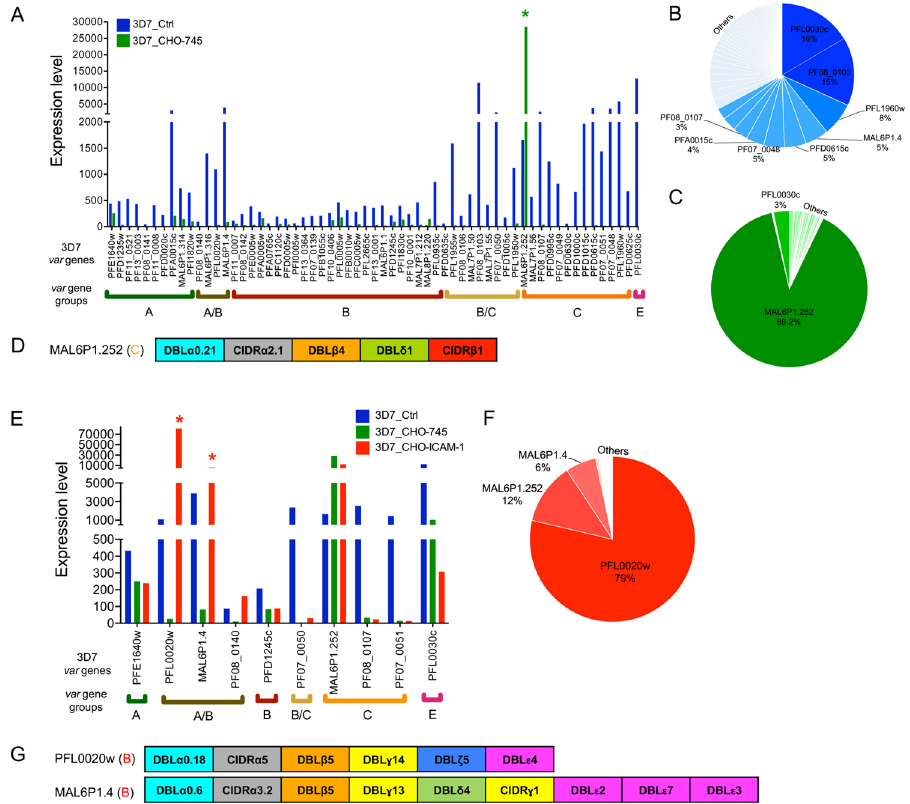
Figure 5. Enrichment of a P. falciparum 3D7 population for parasites binding to CHO-745 WT cells (3D7_CHO-745) and for ICAM-1–binding parasites (3D7_CHO-ICAM-1). ( A ) var gene expression in long-term cultured 3D7 parasites (3D7_Crtl) and 3D7_CHO-745 parasites (expression level is defined as average of the normalized read counts). A var gene with significantly increased expression in 3D7_CHO-745 parasites in comparison with 3D7_Ctrl parasites is marked by a green star (padj < 0.05). ( B ) Distribution of var gene expression in the 3D7_Ctrl population. ( C ) Distribution of var gene expression in the 3D7_CHO- 745 population. ( D ) Schematic representation of Pf EMP1 protein encoded by the MAL6P1.252 gene with significantly increased expression in 3D7_CHO-745 parasites. ( E ) The expression of a selected set of var genes in 3D7_CHO-745–ICAM-1 parasites in comparison with long-term cultured 3D7 parasites (3D7_Crtl) and a 3D7 population enriched for parasites binding to CHO-745 cells (3D7_CHO-745). var genes with significantly increased expression in the 3D7_CHO-745–ICAM-1 parasites are marked by red stars (padj < 0.05). ( F ) Distribution of var gene expression in the 3D7_CHO-745–ICAM-1 population. ( G ) Schematic representation of Pf EMP1 proteins encoded by PFL0020w and MAL6P1.4 genes with significantly higher expression in 3D7_ CHO-745–ICAM-1 than in 3D7_Crtl and 3D7_CHO